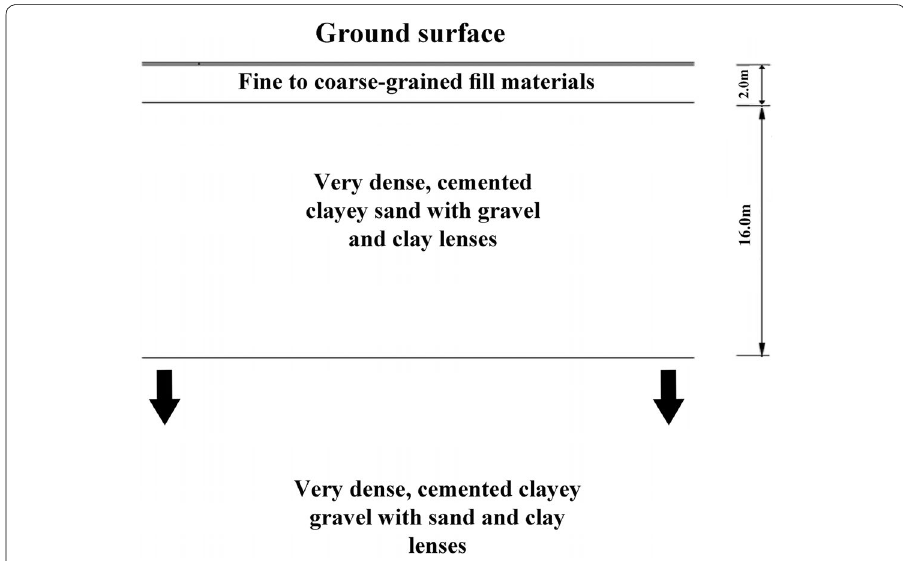
Fig. 1 Soil model at Soheil commercial complex